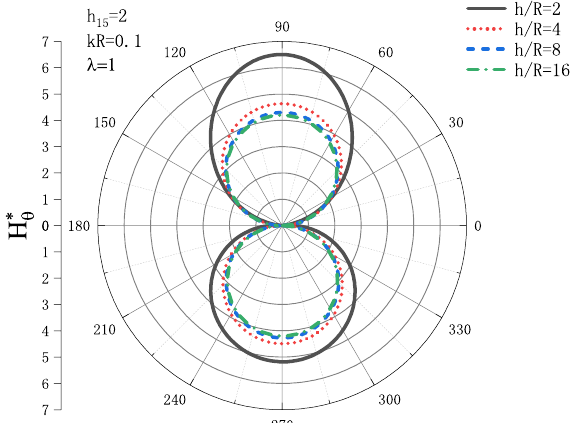
* θ vs. the ratio of